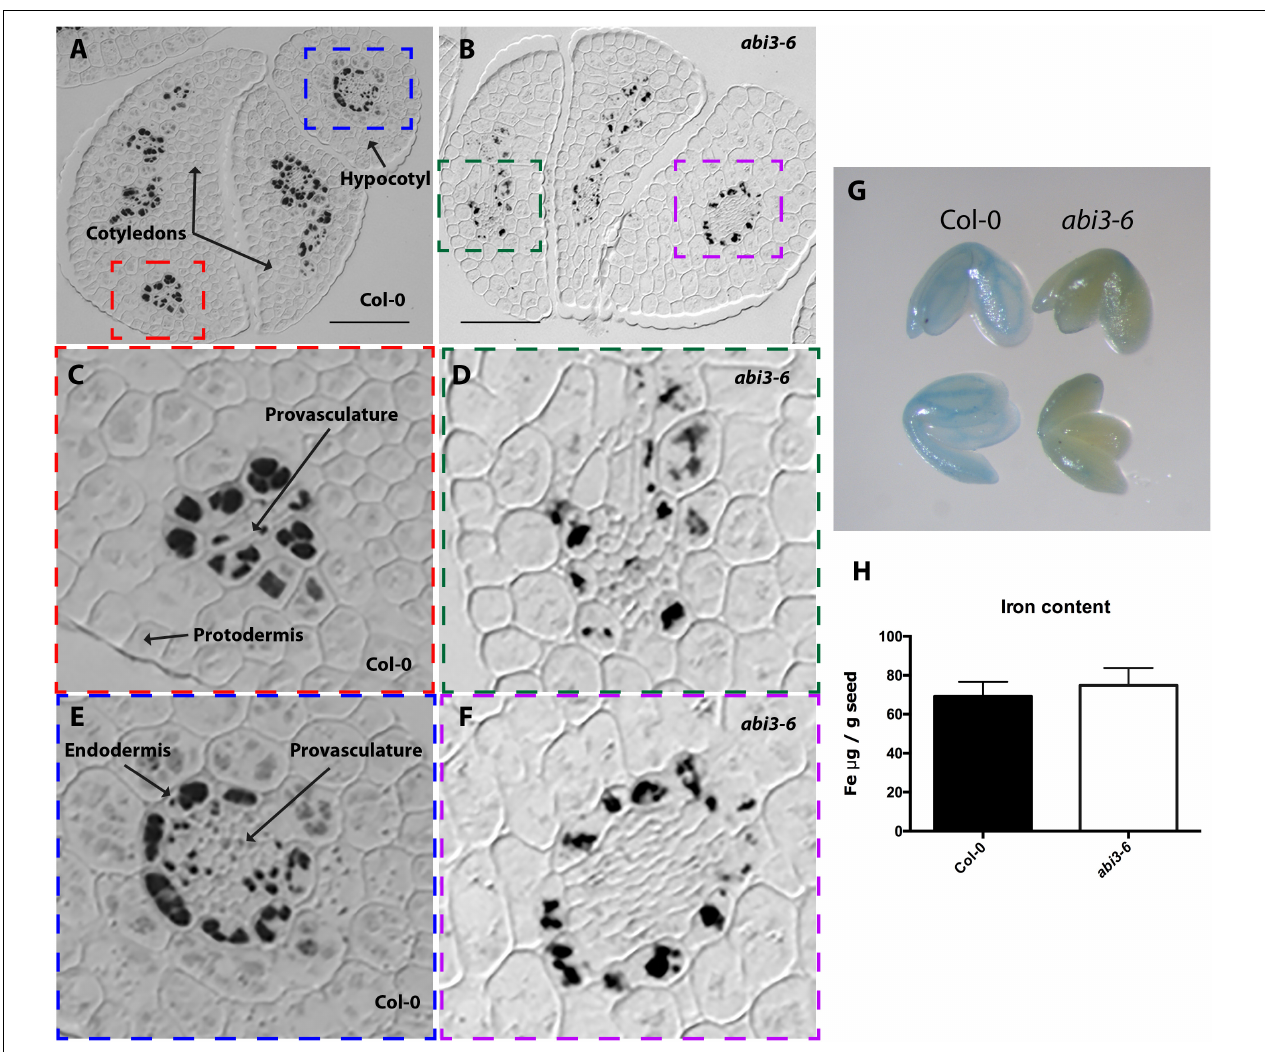
FIGURE 4 | Iron distribution and accumulation in abi3-6 mutants. Histological section of dry seed of Arabidopsis thaliana Col-0 (A,C,E) and abi3-6 (B,D,F) stained with Perls/DAB. (C,D) Cotyledons and (E,F) hypocotyl zoomed zones highlighted in colors in A and B. Bars = 50 µ m. (G) Perls staining in whole embryo, in the left Col-0 embryos, in the right abi3-6 embryos. (H) Iron content in dry seed of Col-0 and abi3-6 . Four samples were analyzed for each